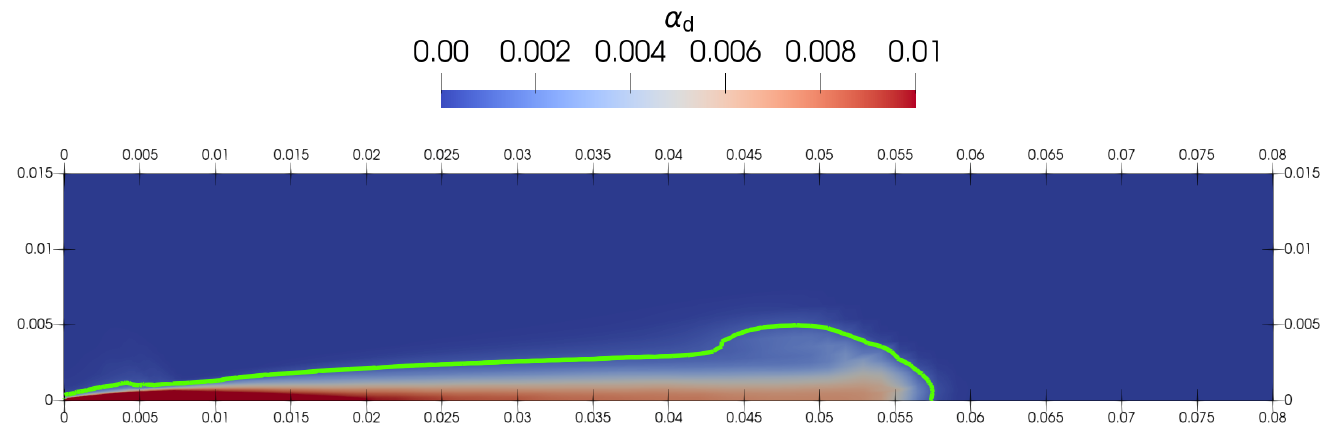
Figure 6. Liquid spray at t = 1.4 ms. The green line gives the iso-contour α d =